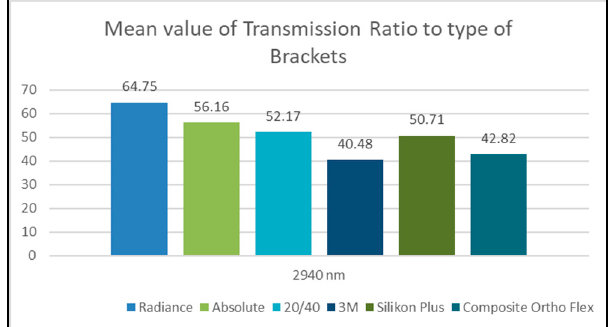
Figure 3. Mean of transmission ratio values according to type of bracket at 2940 nm wavelength.